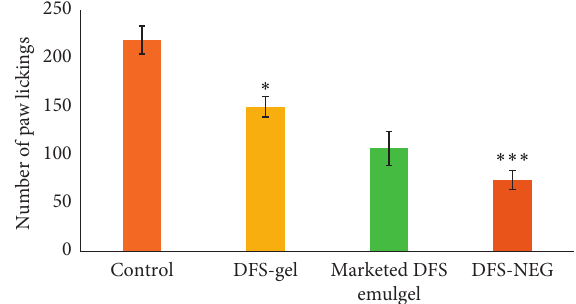
Figure 7: Showing the paw licking activity of various formulations. Blank � control; ∗ p < 0 . 05 vs blank; ∗∗∗ p < 0 . 001 vs blank.